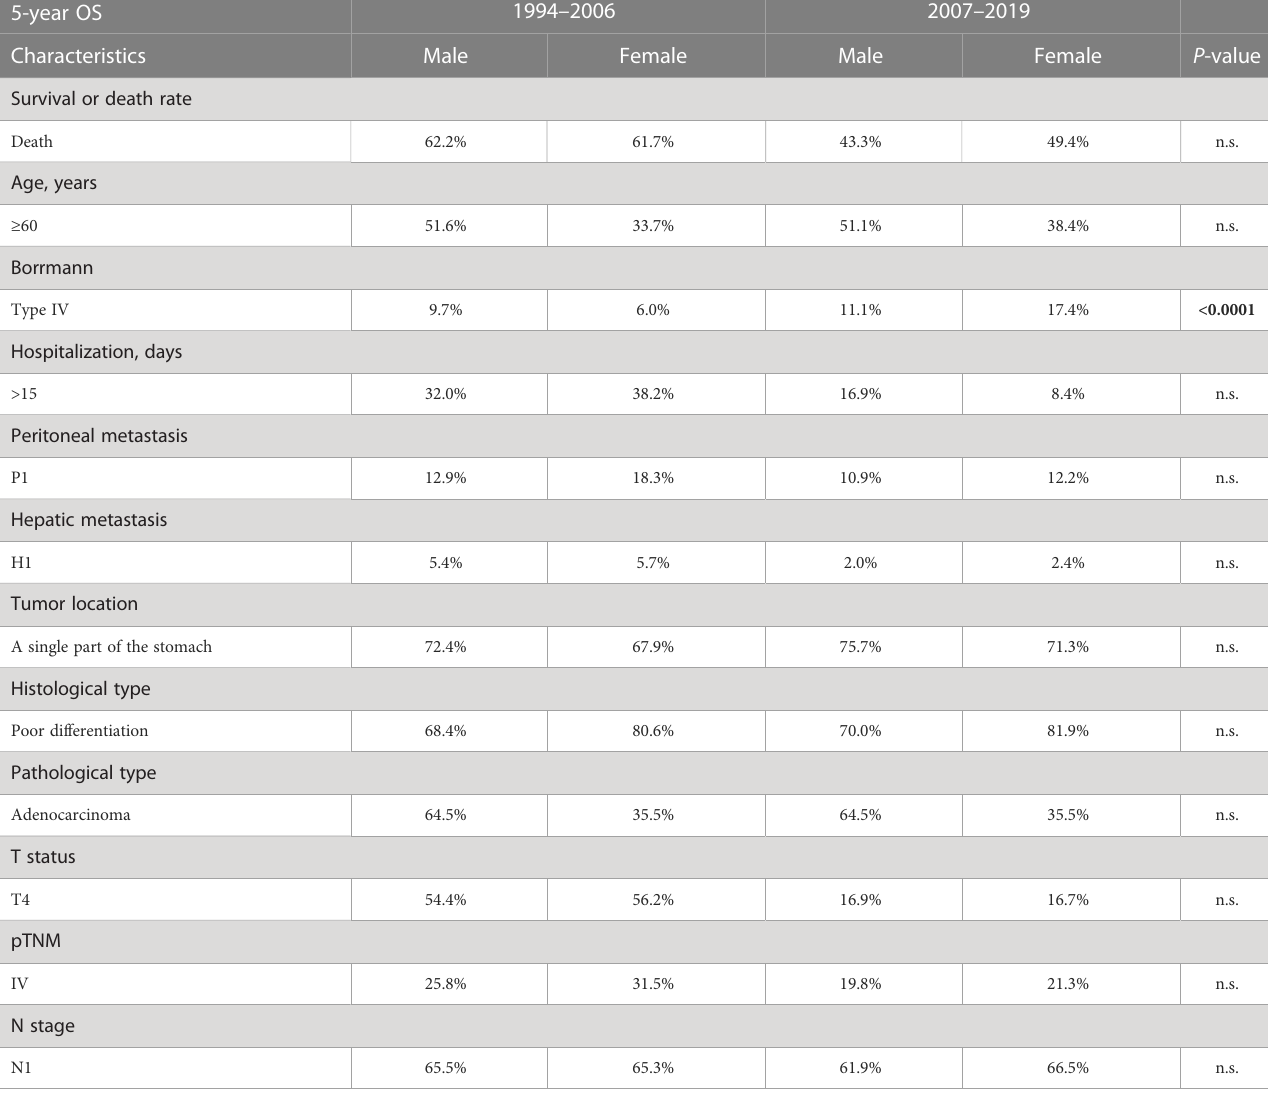
TABLE 5 Trends of hazards of 5-year overall survival characteristics in the female